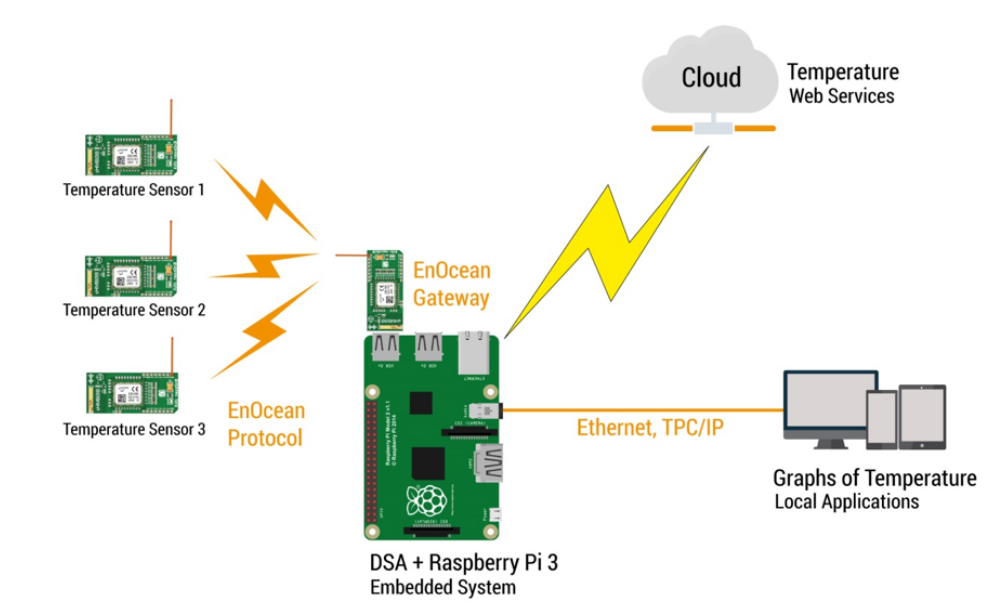
Figure 1. Architecture of the IoT